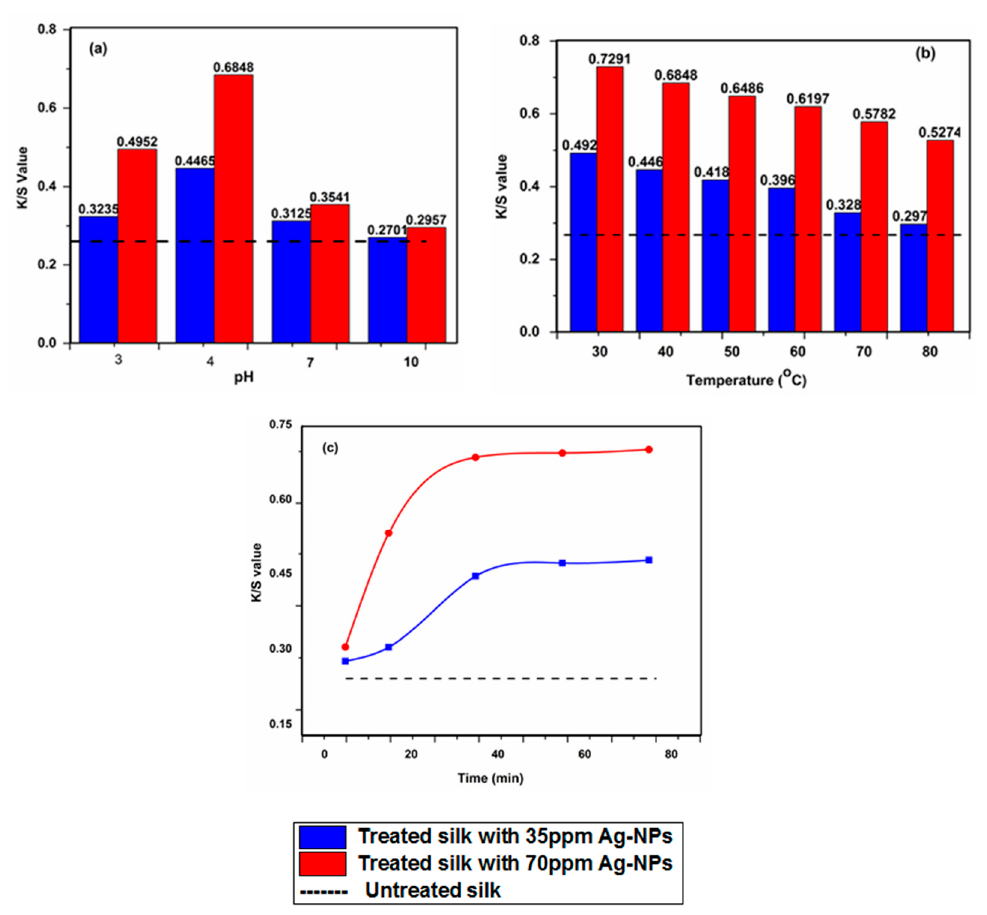
Figure 2. Effect of the ( a ) pH (time 40 min, temp 40 ◦ C); ( b ) temperature (pH 4, time 40 min); and ( c ) effect of the application time (pH 4, temp 40 ◦ C) on the particle uptake in terms of K/S value.